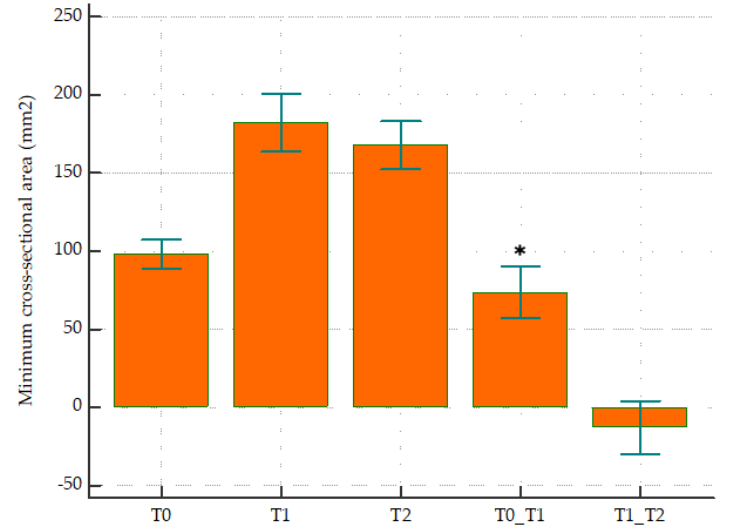
Figure 3. Minimum cross-sectional area (mm 2 ) at (T0) before surgery, (T1) immediately after surgery, (T2) 1-year follow-up, T0 to T1, and T1 to T2 time intervals. * represents statistical significance ( p < 0.05).